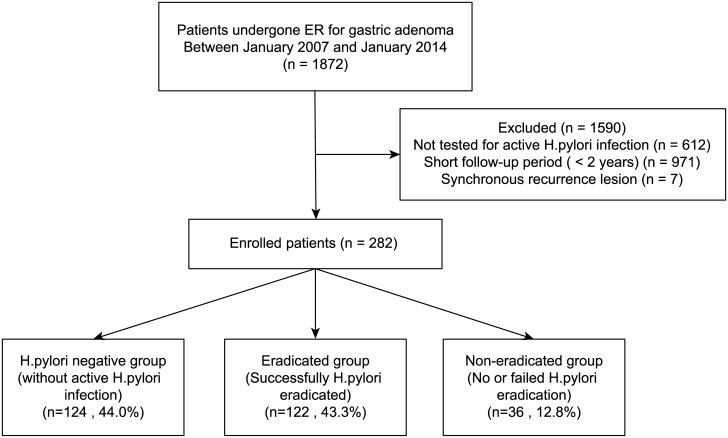
A flow chart of patient enrollment.